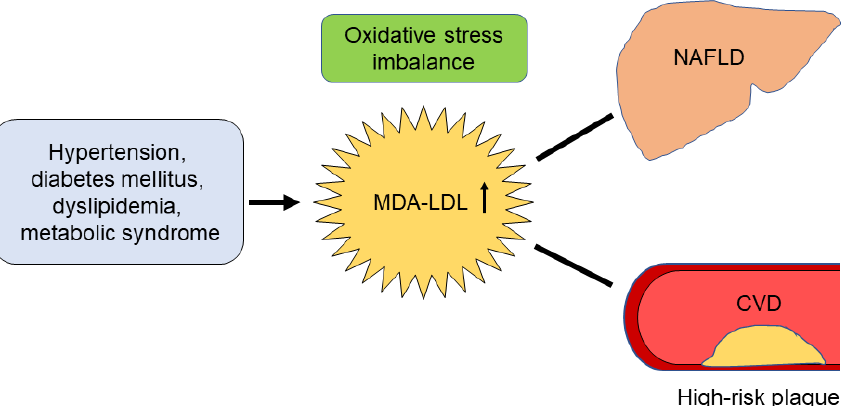
Figure 2. Possible pathological mechanisms linking nonalcoholic fatty liver disease and cardiovascular disease. MDA-LDL, malondialdehyde-modified low-density lipoprotein; NAFLD, nonalcoholic fatty liver disease; CVD, cardiovascular disease.